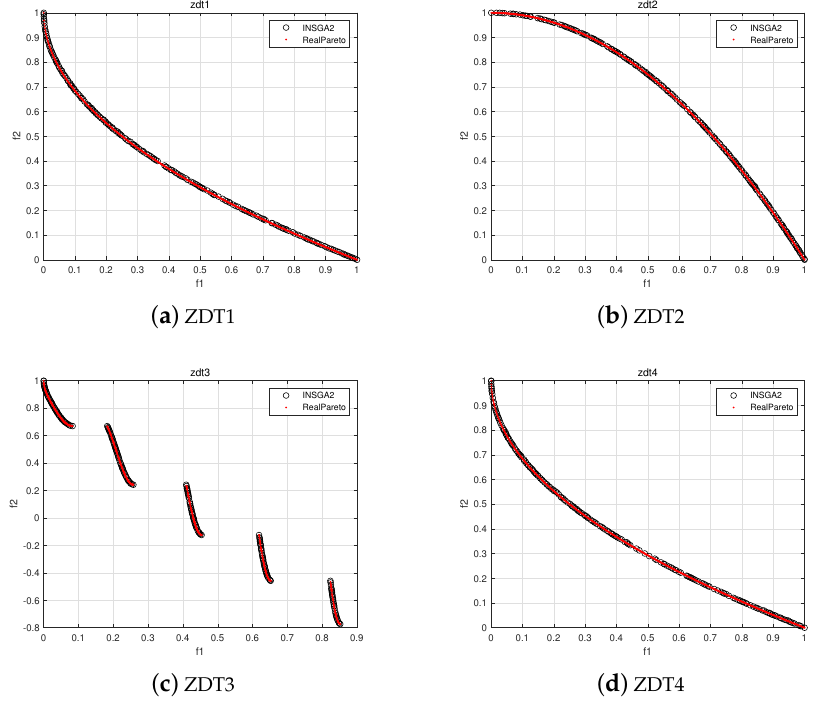
Figure 2. Solutions with INSGA-II on ZDT test